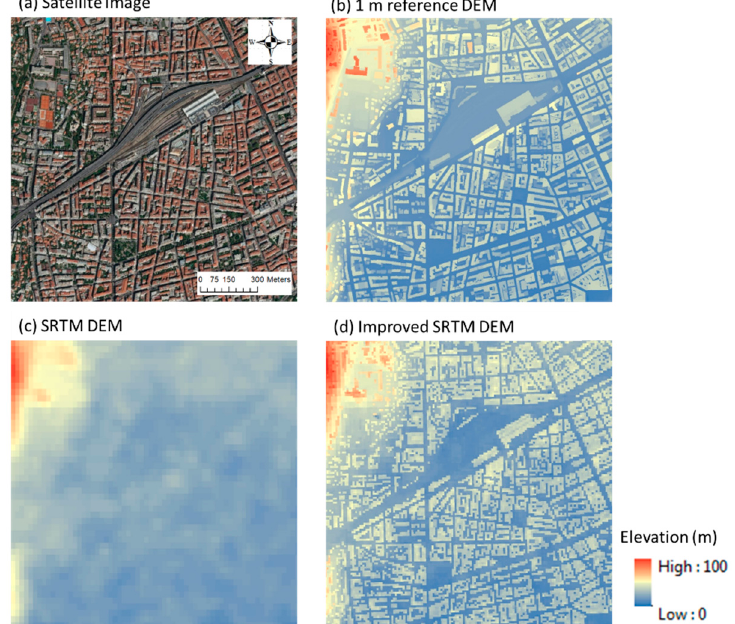
Figure 5. Comparisons of ( a ) satellite image, ( b ) 1 m reference DEM, ( c ) SRTM DEM and ( d ) improved SRTM (iSRTM) DEM in dense urban area in Nice.